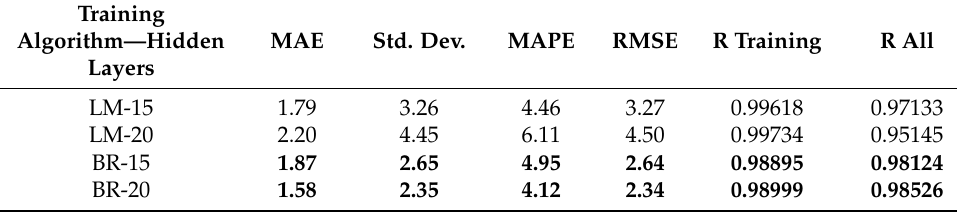
Table 3. Summary of results obtained in ANN